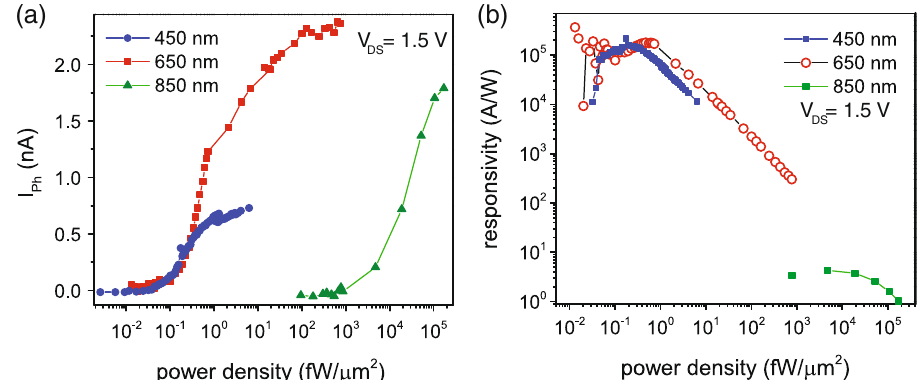
Fig. 4 For device D 3. a Photo current ( I ph ) as function of optical power density for red ( red curve ), blue ( blue curve ), and IR ( green curve ) lEDs. b Photo-responsivity for red, blue, and IR light at V DS = 1.5 V. Though for red and blue the photo-responsivity was similar and of the order of 10 5 A/W, for IR it is several orders of magnitude small